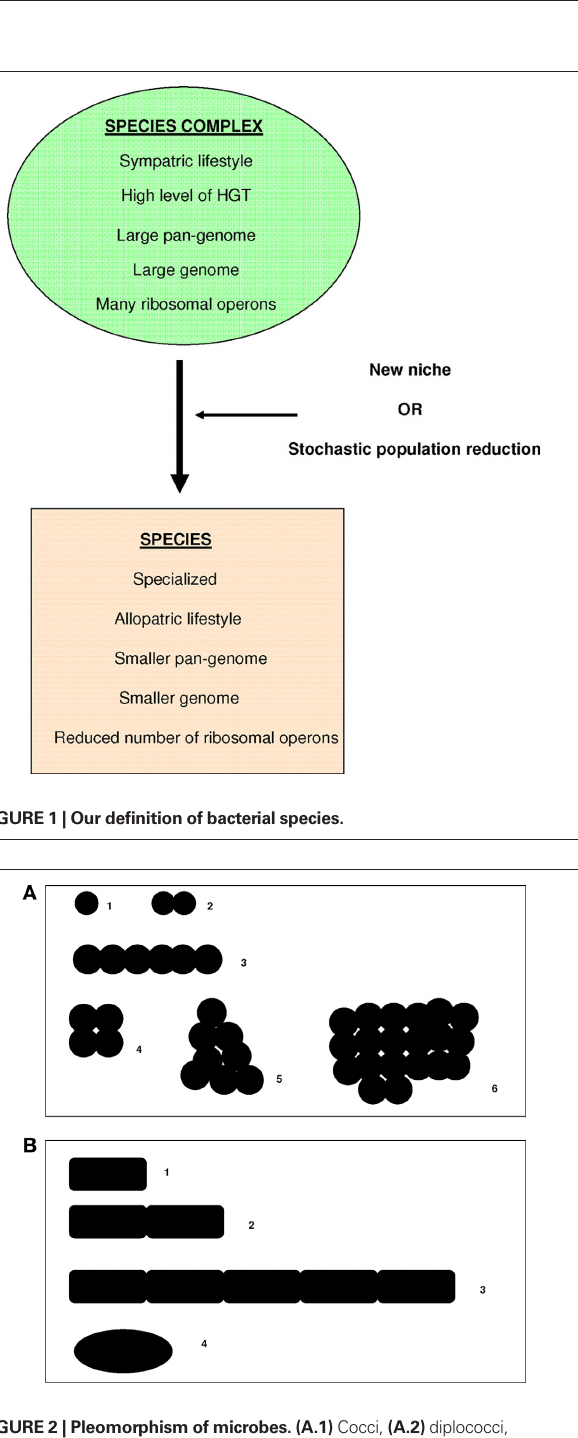
Figure 2 | Pleomorphism of microbes. (A.1) Cocci, (A.2) diplococci, (A.3–5) streptococci, (A.6) staphylococci, (B.1) bacilli, (B.2) diplobacilli, (B.3) streptobacilli, and (B.4)